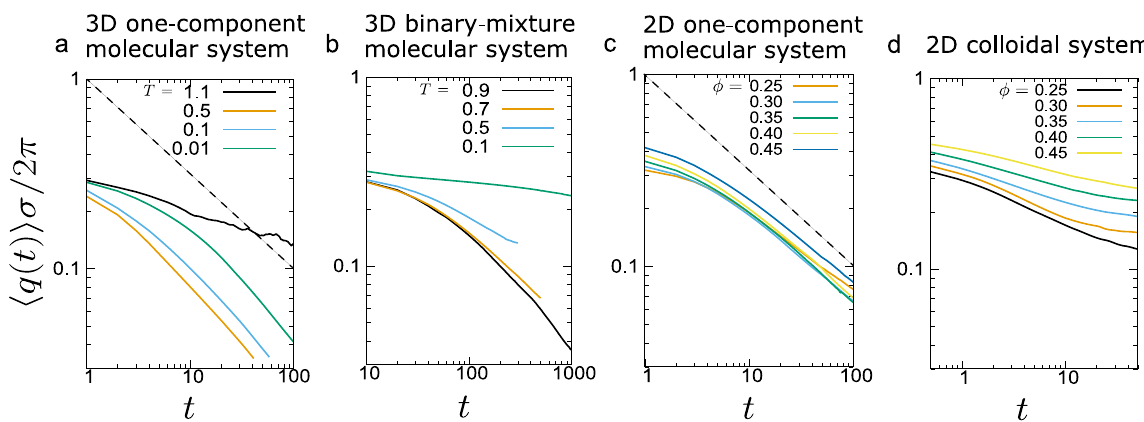
Fig. 6 Temporal change of the characteristic wavenumber 〈 q 〉 in phase separation of various systems studied. a A single-component fl uid system in 3D ( ρ = 0.33, T = 0.01, 0.1, 0.5, 1.1; ρ c ~ 0.33, T c ~ 1.2). b A 50-50 dynamically symmetric mixture of a two-component fl uid system in 3D ( ρ = 1.0, T = 0.1, 0.5, 0.7, 0.9; ρ c = 0.5, T c ~ 1.4). c A single-component fl uid system in 2D at T = 0.3. d Colloidal suspensions in 2D at the same parameter setting as in 3D. The dashed lines in panels a and c have a slope